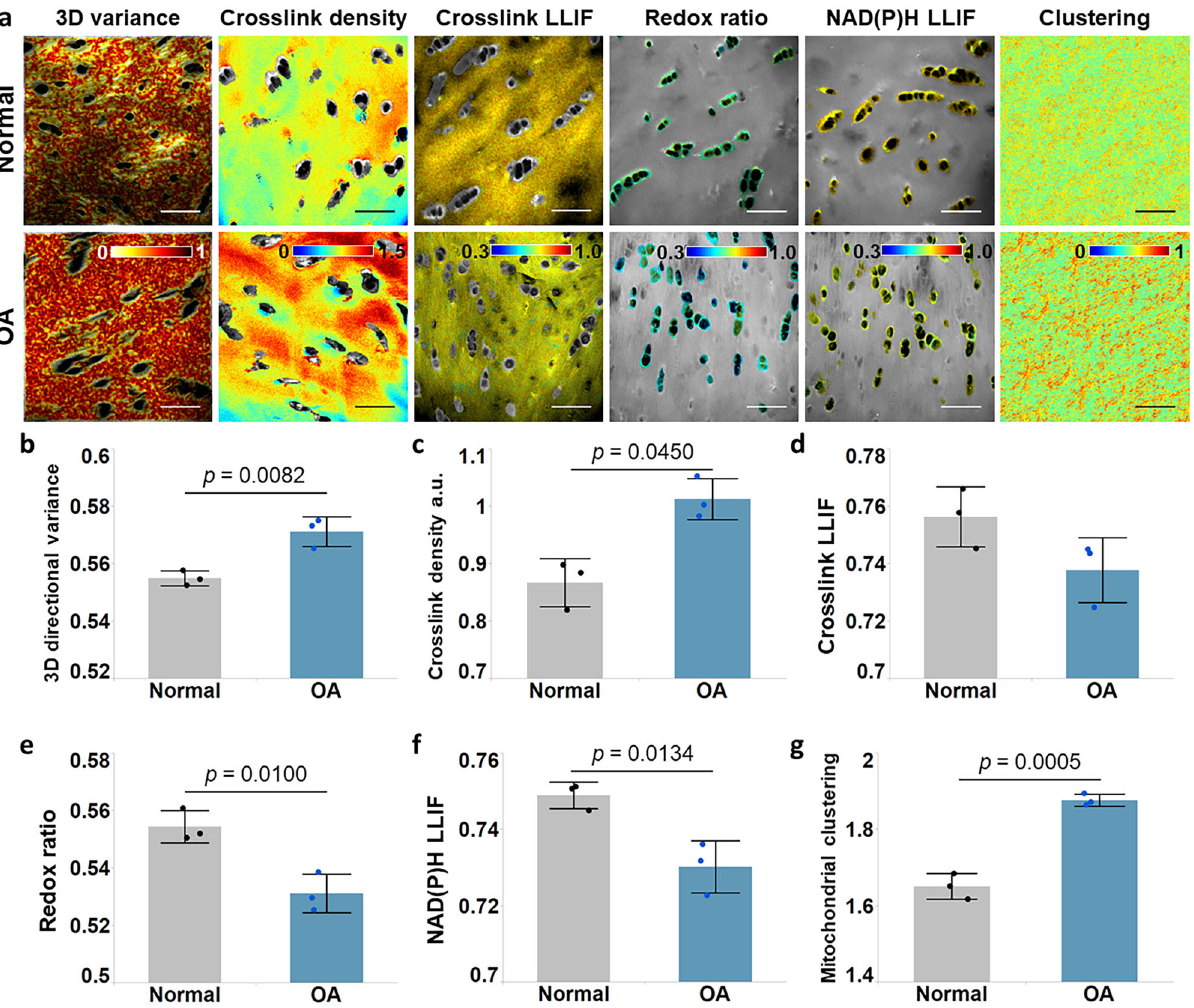
Fig. 4 Measures of 3D collagen fi ber organization, cross-link degradation, and cellular metabolism in human articular cartilage suffering from OA. a Representative maps of (from left to right): 3D directional variance, cross-link density, cross-link LLIF, redox ratio, NAD(P)H LLIF and mitochondrial clustering, obtained from normal (top) or OA samples (bottom). Patient-based mean and standard deviation of b 3D directional variance, c cross-link density, d cross-link LLIF, e redox ratio, f NAD(P)H LLIF, and g mitochondrial clustering, with p values indicated in each graph. n = 3 patients for each group. Scale bar: 50 µ